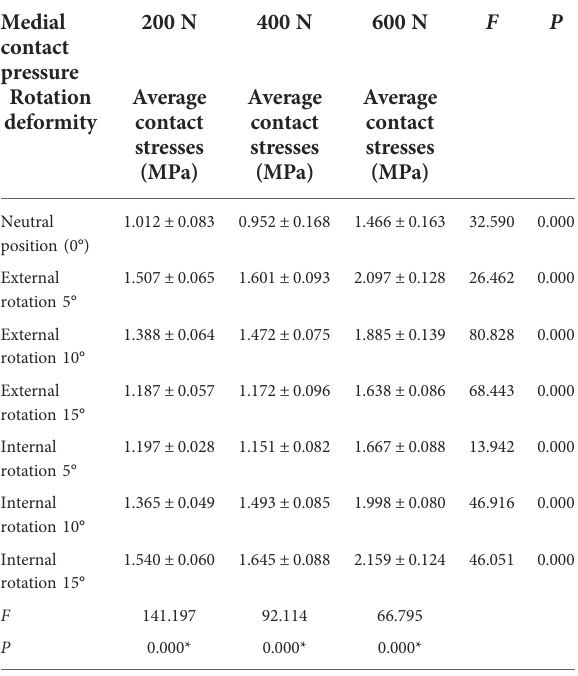
TABLE 1 Value of medial femoral – tibial contact compression at various rotatory angles (MPa).